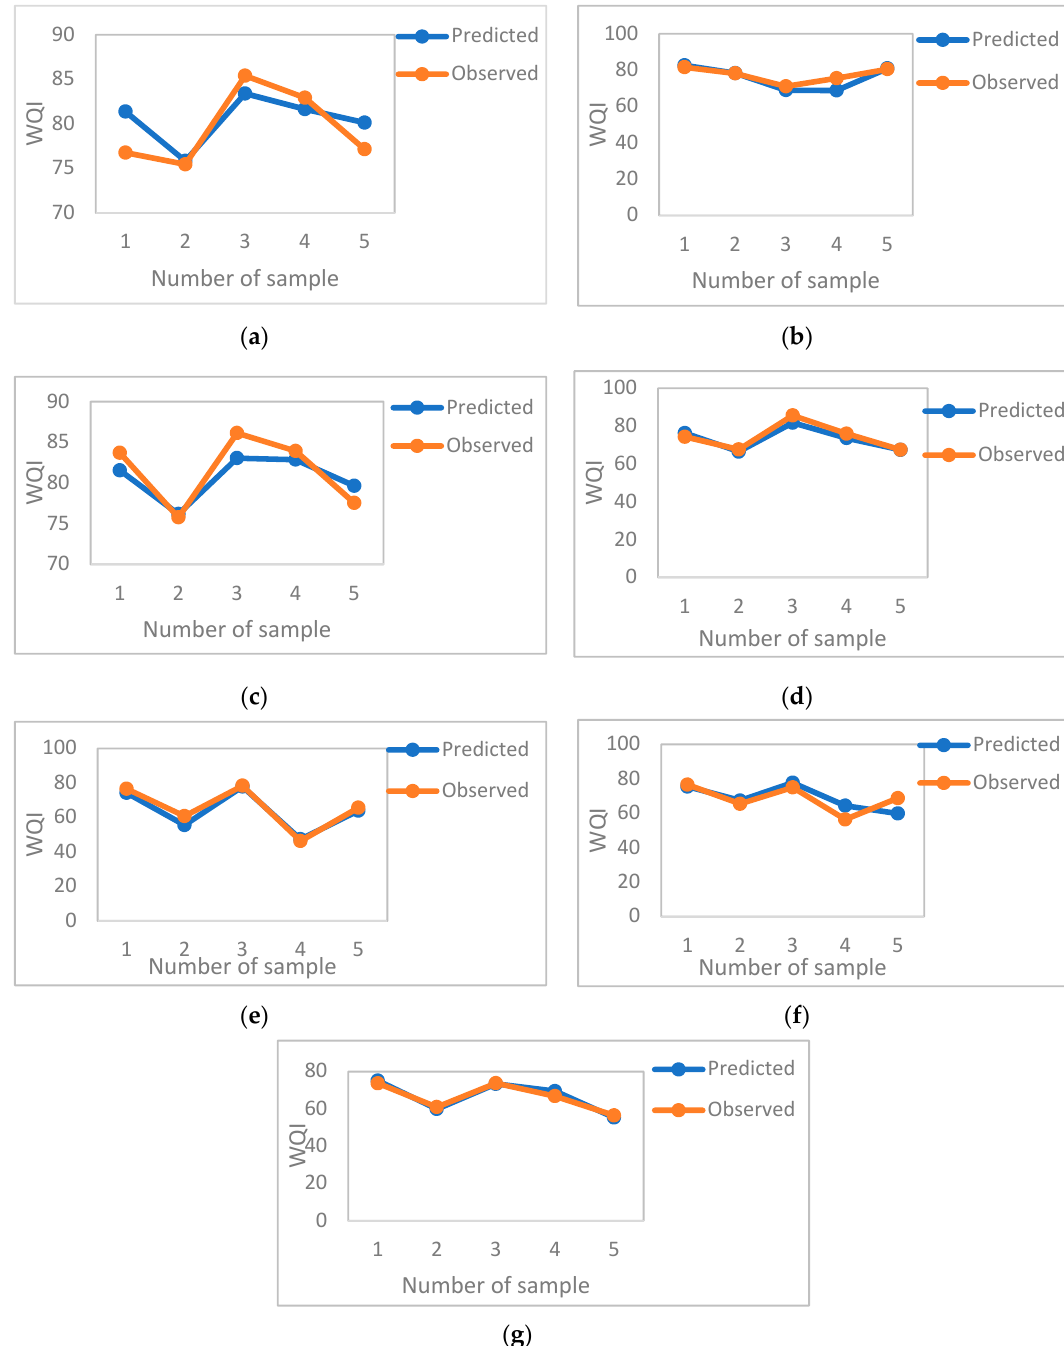
Figure 13. Series of observed and predicted WQI values during training phase ( a ) upstream, ( b ) discharge point, ( c ) A, ( d ) B, ( e ) C, ( f ) D, and ( g ) E in the dry season. Table 11. Performance of the ANN model for the dry season.